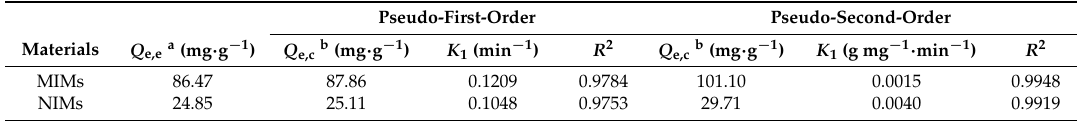
Table 3. Kinetic constants of the pseudo-first-order and